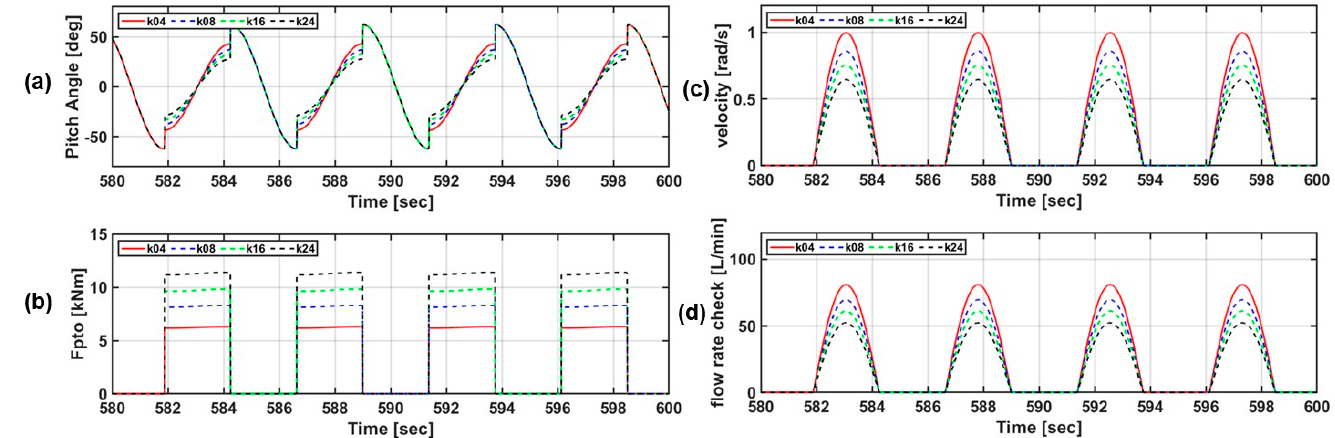
Figure 13. ( a ) Float pitch angle, ( b ) F pto , ( c ) float velocity, and ( d ) generated flow rate according to the torque coefficient of the optimal torque control algorithm under regular wave conditions (legends indicate torque coefficients).